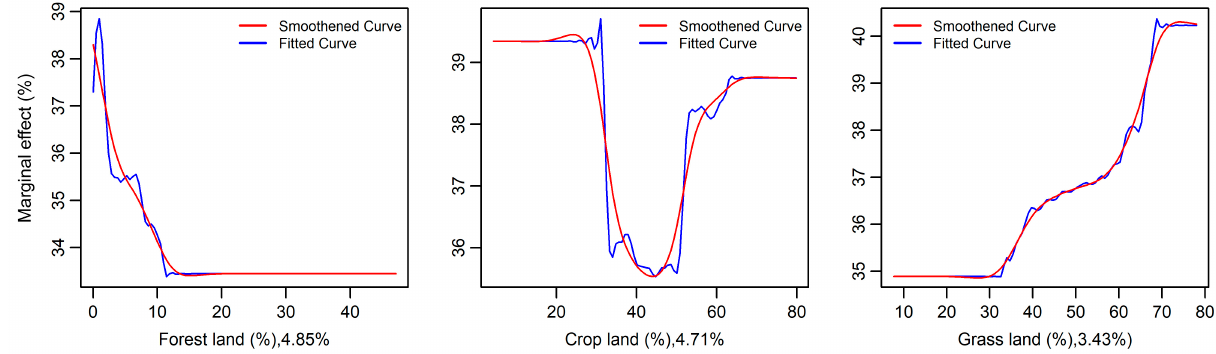
Figure 7. The relationships between land-use resources and RPI.